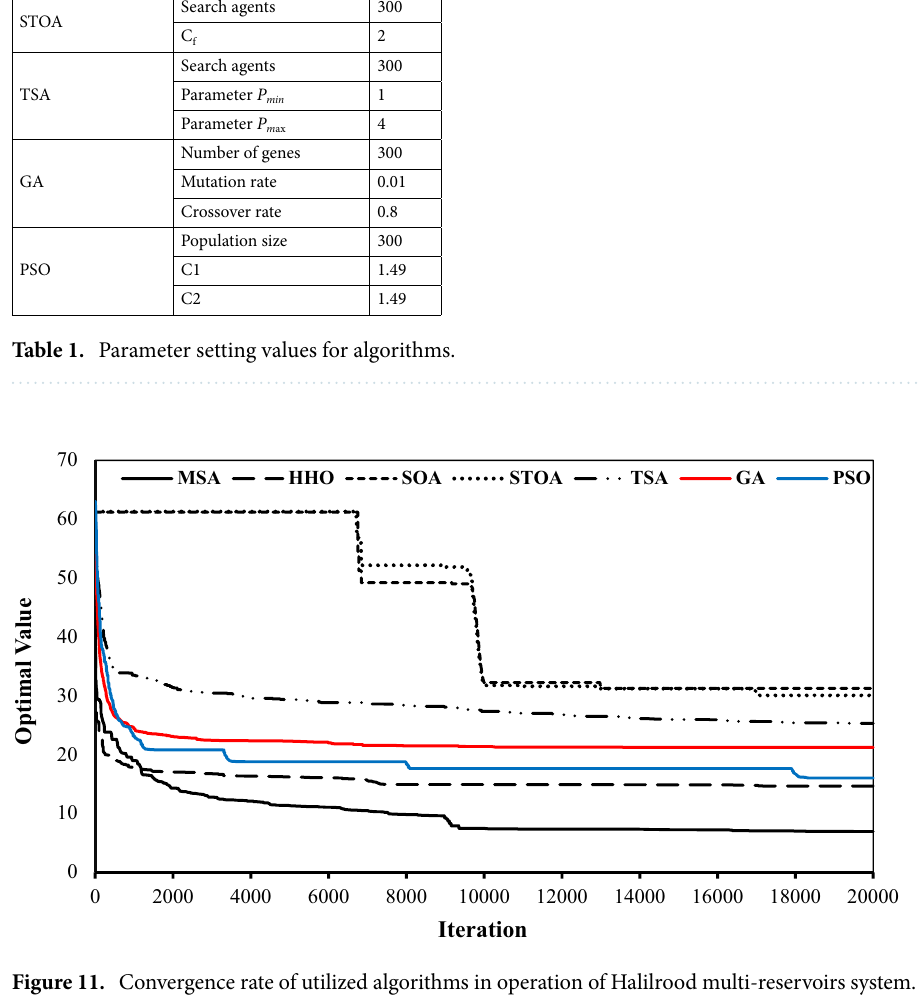
Figure 11. Convergence rate of utilized algorithms in operation of Halilrood multi-reservoirs